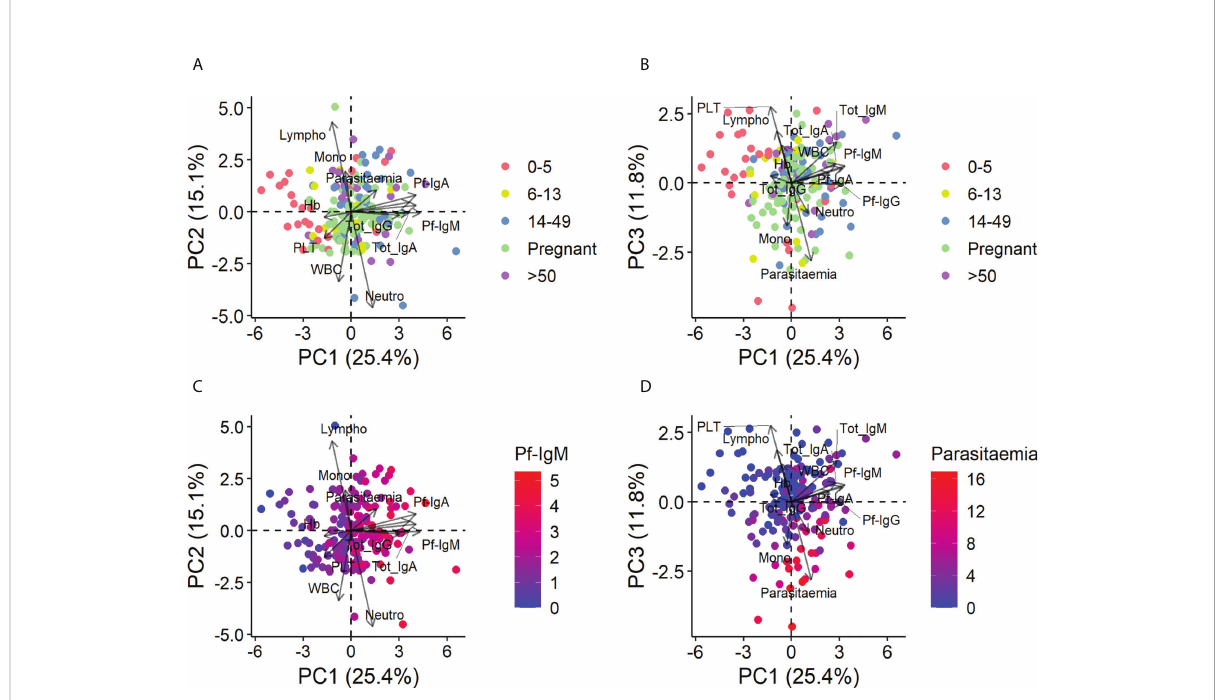
FIGURE 2 Principal components analysis of all quantitative variables in the entire population. Data were log 2 -transformed with a pseudo-count of 1 and standardized into z-scores prior to analysis. (A) Principal component (PC) 1 vs. PC2 colored by age and pregnancy group. (B) PC1 vs. PC3 colored by age and pregnancy group. (C) PC1 vs. PC2 colored by the level of Pf-IgM, the principal contributor to PC1. (D) PC1 vs. PC3 colored by the level of parasitemia, the principal contributor to